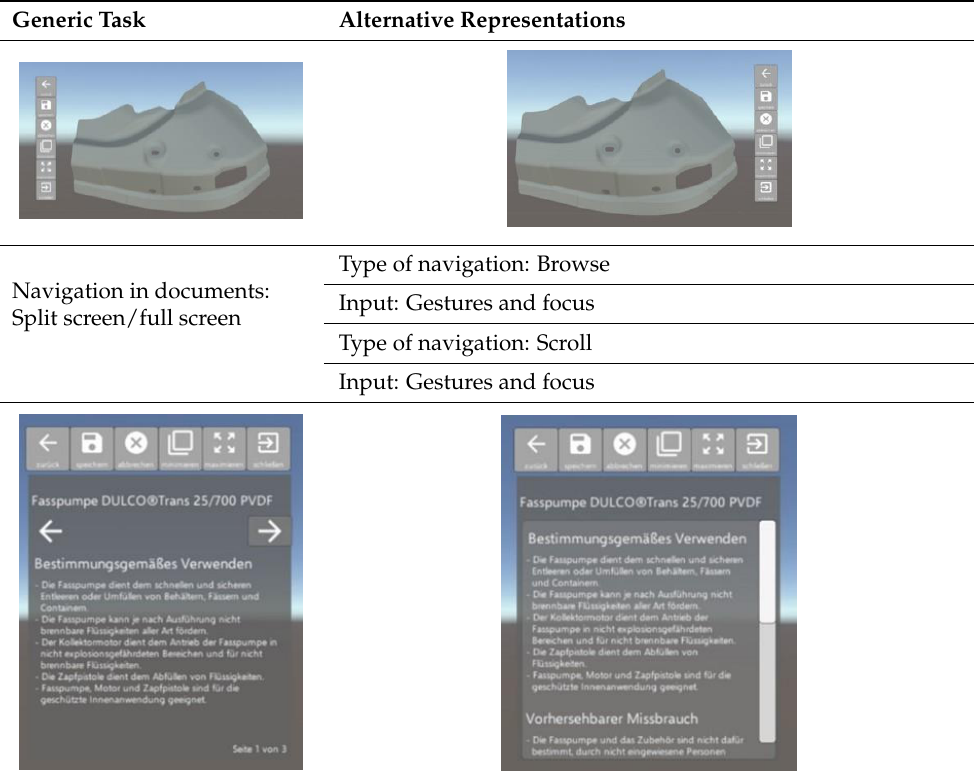
Table 7. Cont. Generic Task Alternative